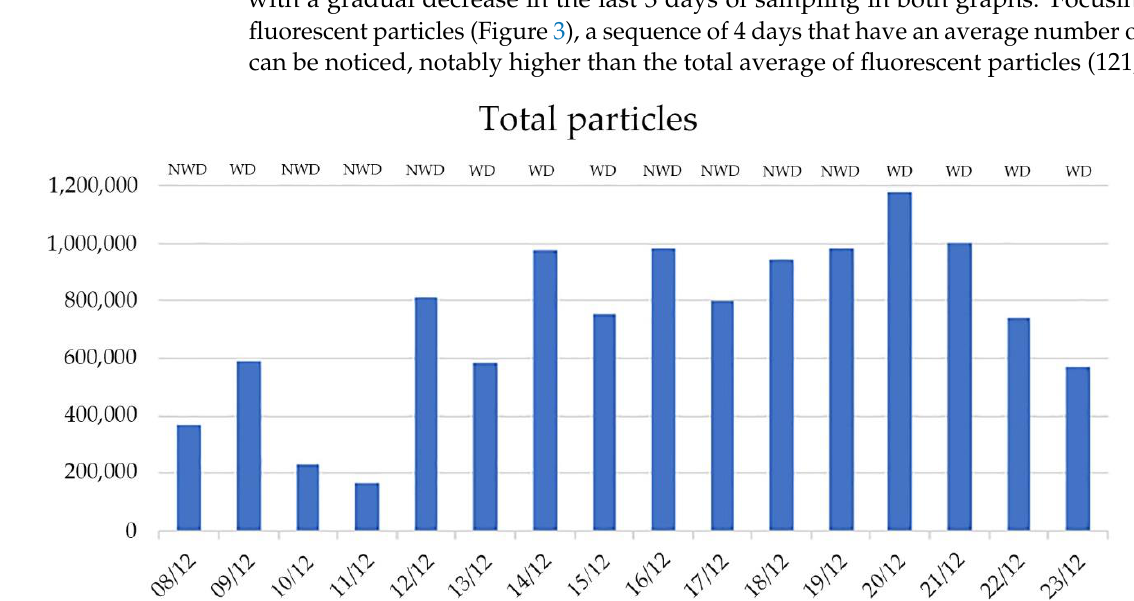
Figure 2. Number particles (y-axis) for each day of sampling (x-axis).